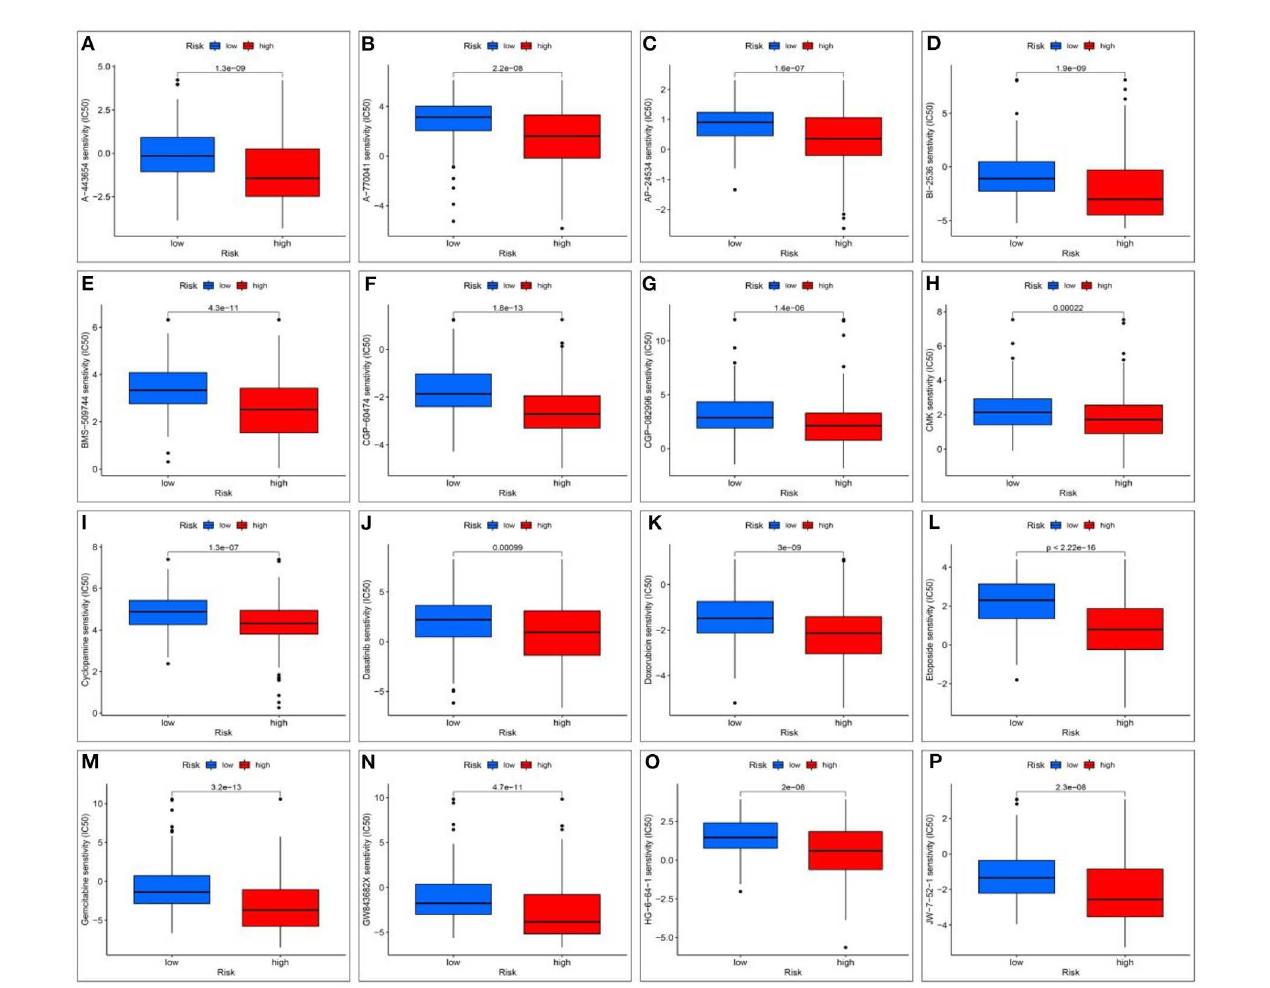
FIGURE13 Screening for potential drugs; (A) The therapeutic effect of the drug A-443654; (B) The therapeutic effect of the drug A-770041; (C) The therapeutic effect of the drug AP-24534; (D) The therapeutic effect of the drug BI-2536; (E) The therapeutic effect of the drug BMS-509744; (F) The therapeutic effect of the drug CGP-60474; (G) The therapeutic effect of the drug CGP-082996; (H) The therapeutic effect of the drug RSK2 kinase inhibitor (CMK); (I) Cyclopamine drug’s therapeutic effects; (J) The therapeutic effect of the drug Dasatinib; (K) The therapeutic effect of the drug Doxorubicin; (L) The therapeutic effect of the drug Etoposide; (M) The therapeutic effect of the drug Gemcitabine; (N) The therapeutic effect of the drug GW843682X; (O) The therapeutic effect of the drug HG-6-64-1; (P) The therapeutic effect of the drug